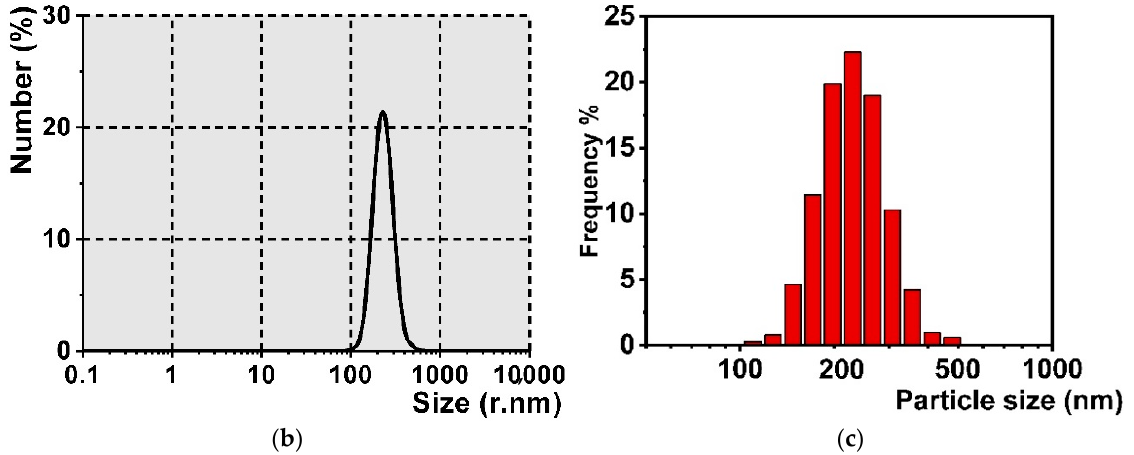
Figure 1. ( a ) TEM images; ( b ) DLS; ( c ) particle size distribution of the as-prepared ormosil nanosensor.